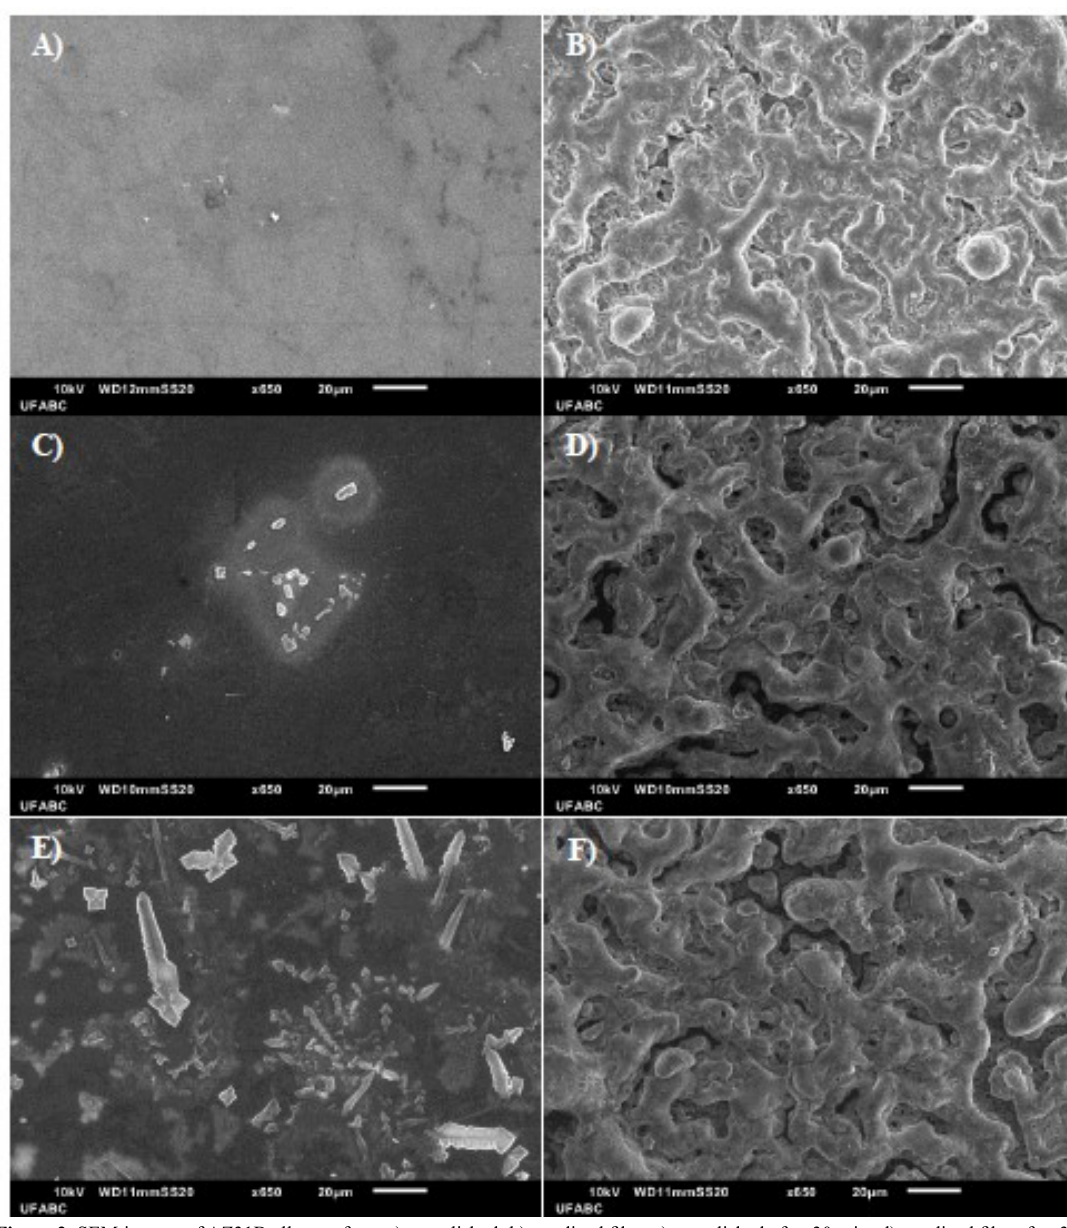
Figure 2. SEM images of AZ31B alloy surface: a) as-polished; b) anodized film; c) as-polished after 30 min; d) anodized film after 30 min; e) as-polished after 80 min; f) anodized after 80 min immersed into SBF.